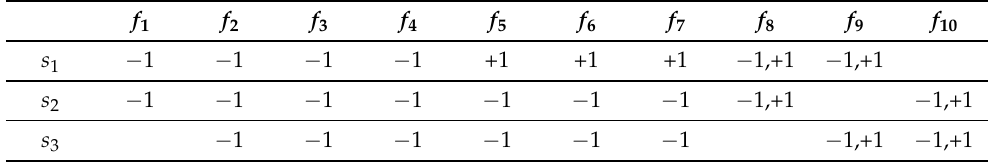
Table 6. Fault Isolation System (FIS).